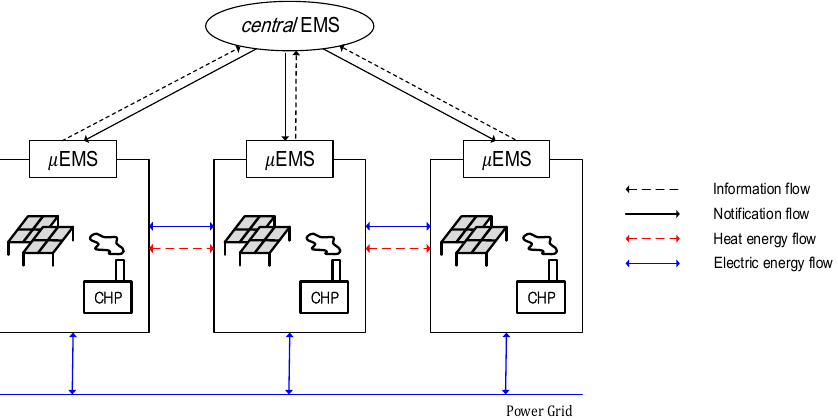
Figure 1. Information and energy flows in cooperative multi-microgrid community. EMS: energy management system; CHP: combined heat and power.